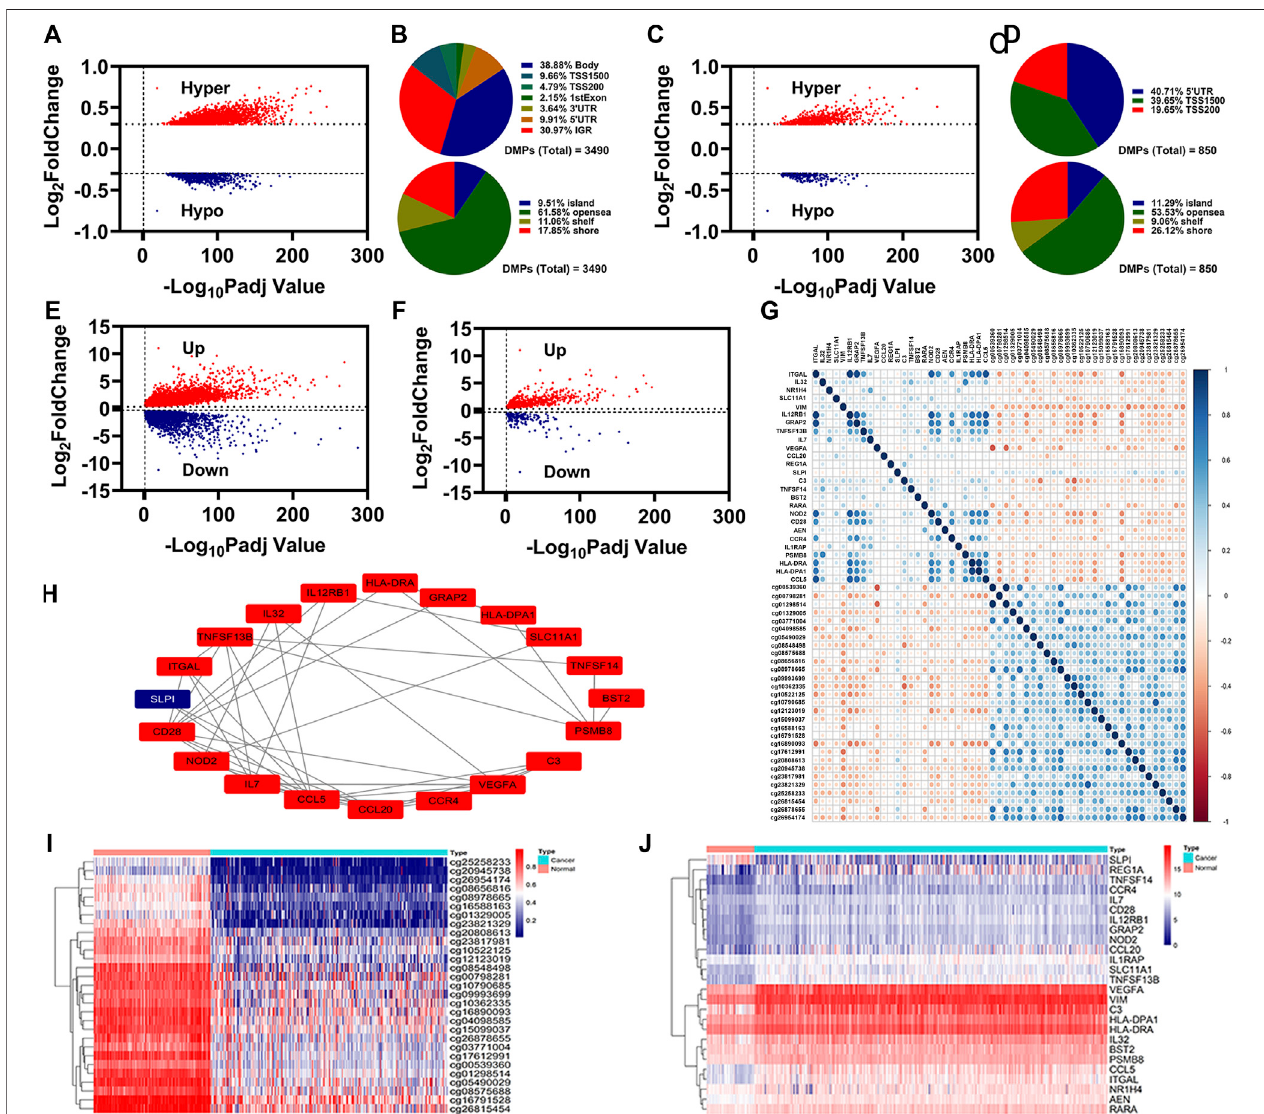
FIGURE1| Identi fi cationofIR-DEGsassociatedwithaberrantmethylations. (A) ,VolcanoplotofDNAmethylationsstatus. (B) ,DistributionoftheDNAmethylations sites for DMPs. (C) , Volcano plot of DNA methylations status for the DMPs in promoter region. (D) , Distribution of the DNA methylations sites for the DMPs in promoter region. e-f, Volcano plot of DEGs (E) and IR-DEGs (F) status. (G) , Correlation of 29 DMPs and 26 IR-DEGs. (H) , Protein interaction of 26 IR-DEGs. i-j, Heatmap of 29 DMPs (I) and 26 IR-DEGs (J) .